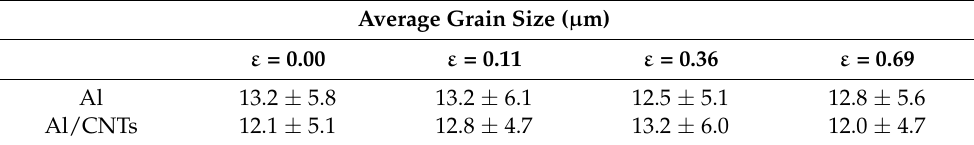
Table 1. The average grain size of Al and Al/CNTs for sintered and cold-rolled